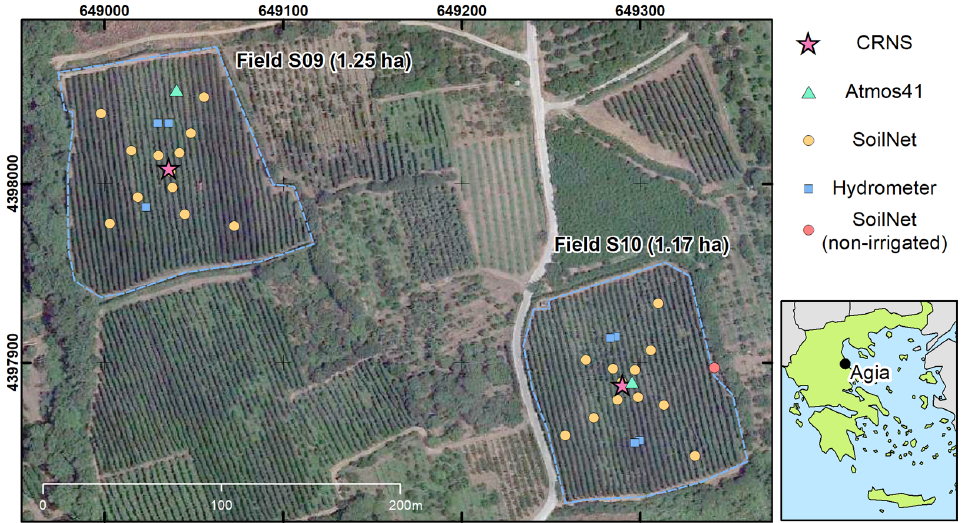
Figure 1. Satellite image [75] of the study area, instrumentation, and land use. Reference system is UTM 1984 Zone 34 North.